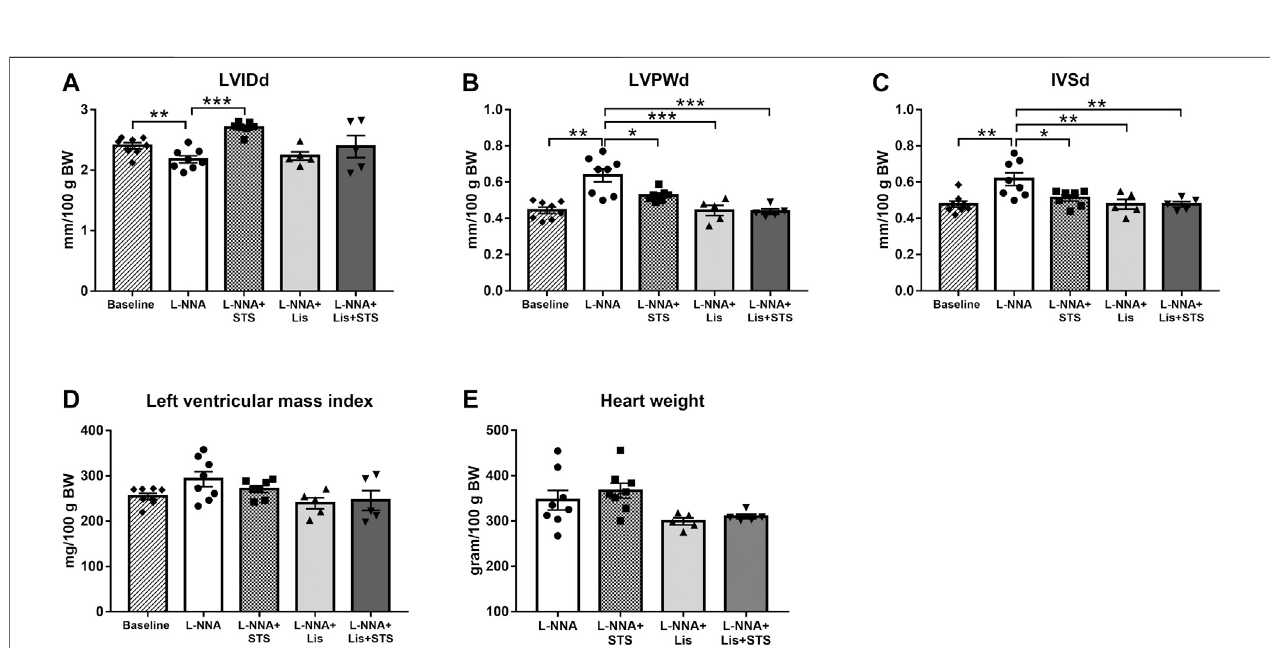
FIGURE 4 | Treatment with STS improved left ventricular posterior and septal wall hypertrophy. (A) Left ventricular internal diameter (LVIDd), (B) left ventricular posterior wall thickness (LVPWd) and (C) interventricular septal wall thickness (IVSd) during diastole were measured via echocardiography. (D) Left ventricular mass index was calculated from these variables and (E) heart weight was measured at the end of the protocol. N (cid:2) 5 – 8. * p < 0.05, ** p < 0.01, *** p < 0.001.